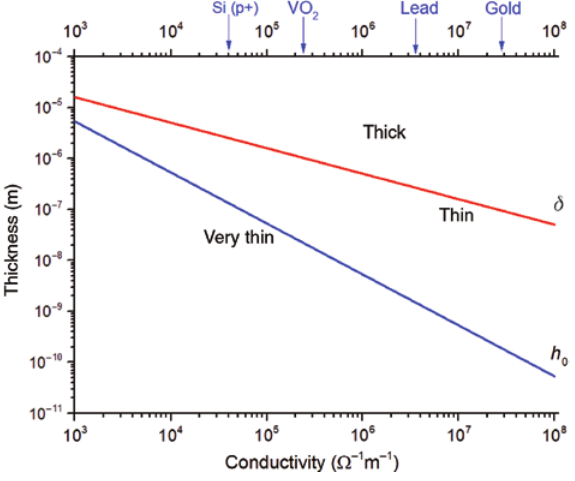
Figure 3: Thickness of metallic thin films in terms of conductivity is plotted. In particular, Si (p + ), VO , lead, and gold cases are denoted in blue 2 arrows. Given conductivities of materials are at 1 THz